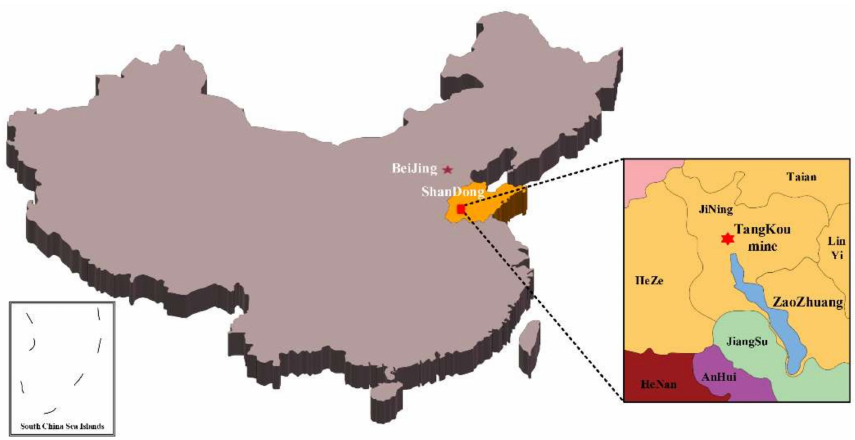
Figure 3. Location of Tangkou Coal Mine, Shandong Province, China.